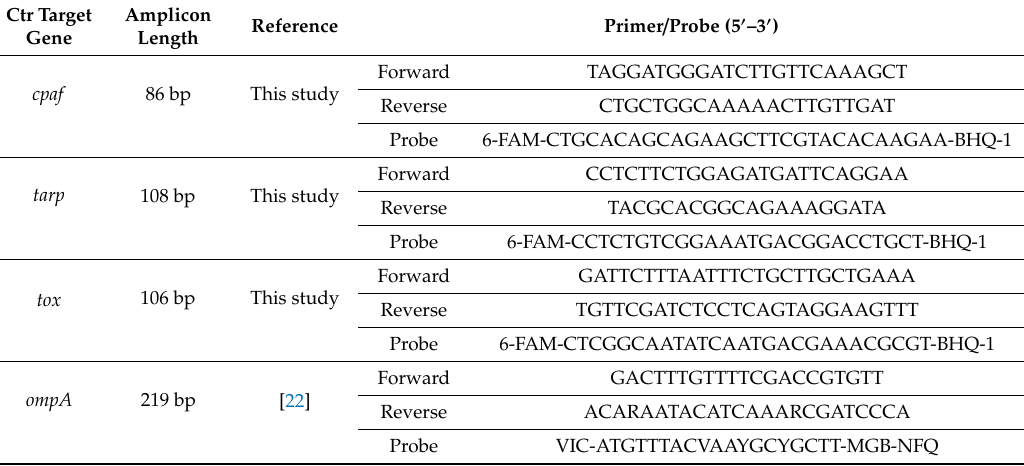
Ctr— C. trachomatis